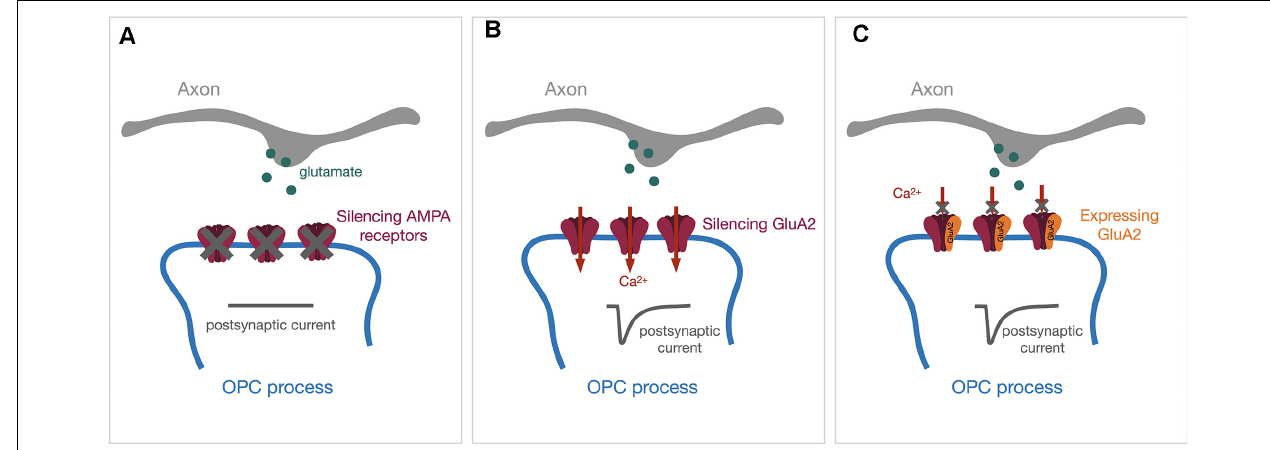
FIGURE 1 | Genetic approaches to manipulate the expression of AMPA receptors in OPCs. Synaptic vesicles containing glutamate (green dots) will be released upon the arrival of action potentials. The release of glutamate will activate post-synaptic AMPA receptors and evoke a post-synaptic current (dark gray traces). (A) Genetically silencing all AMPA receptor subunits will diminish AMPA receptor-mediated postsynaptic currents. (B) Silencing the GluA2 subunit alone will increase Ca 2+ permeability through AMPA receptors. (C) Expressing the GluA2-containing AMPA receptor will block the Ca 2+ entry through AMPA receptors. OPCs, oligodendrocyte precursor